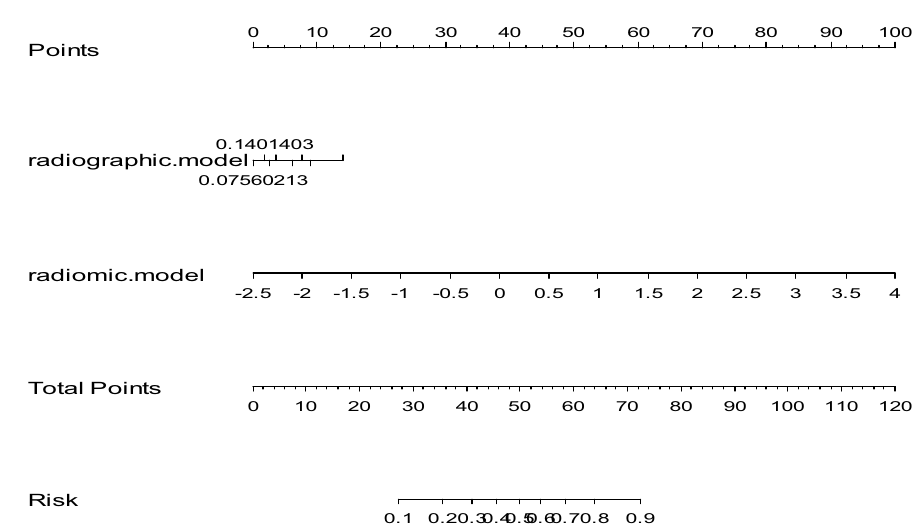
Figure 3. The nomogram was developed incorporating radiomics model on CECT with radiographic signature.